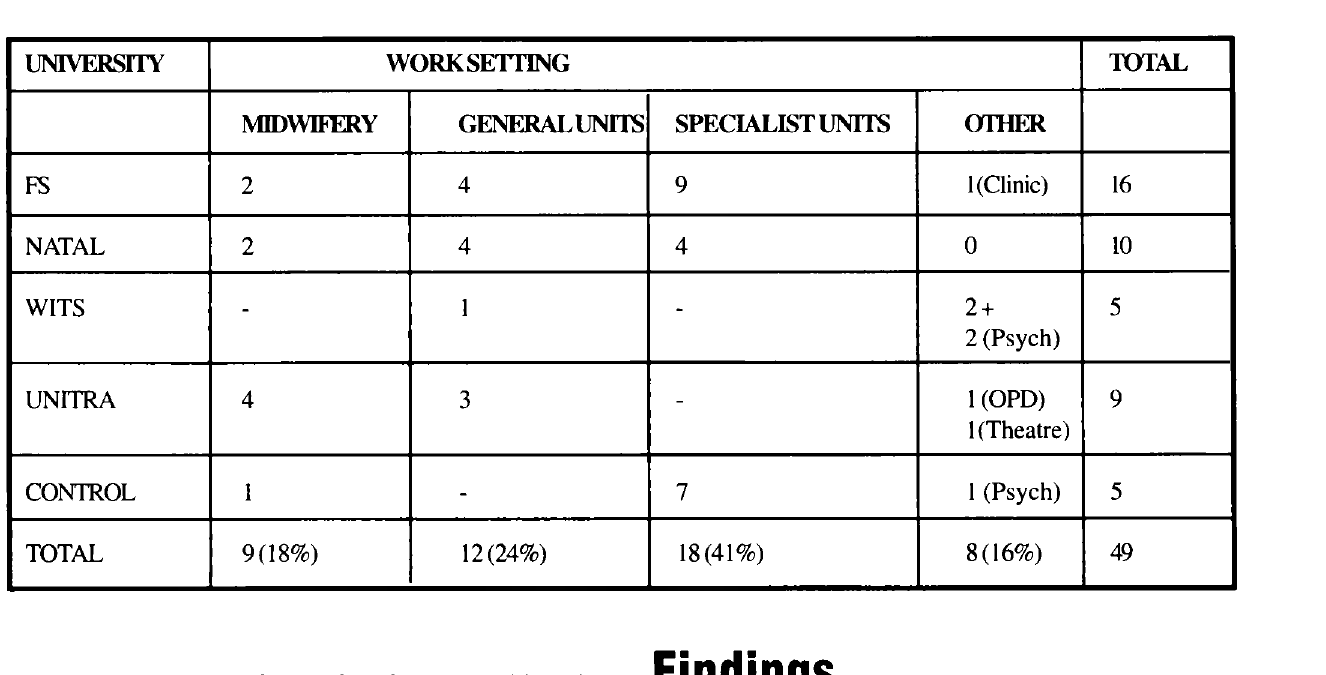
Table 1 : Work setting of graduates